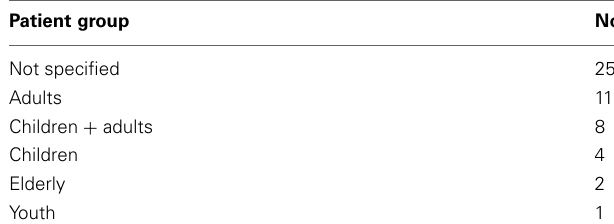
Table 2 | Patient groups covered by the selected